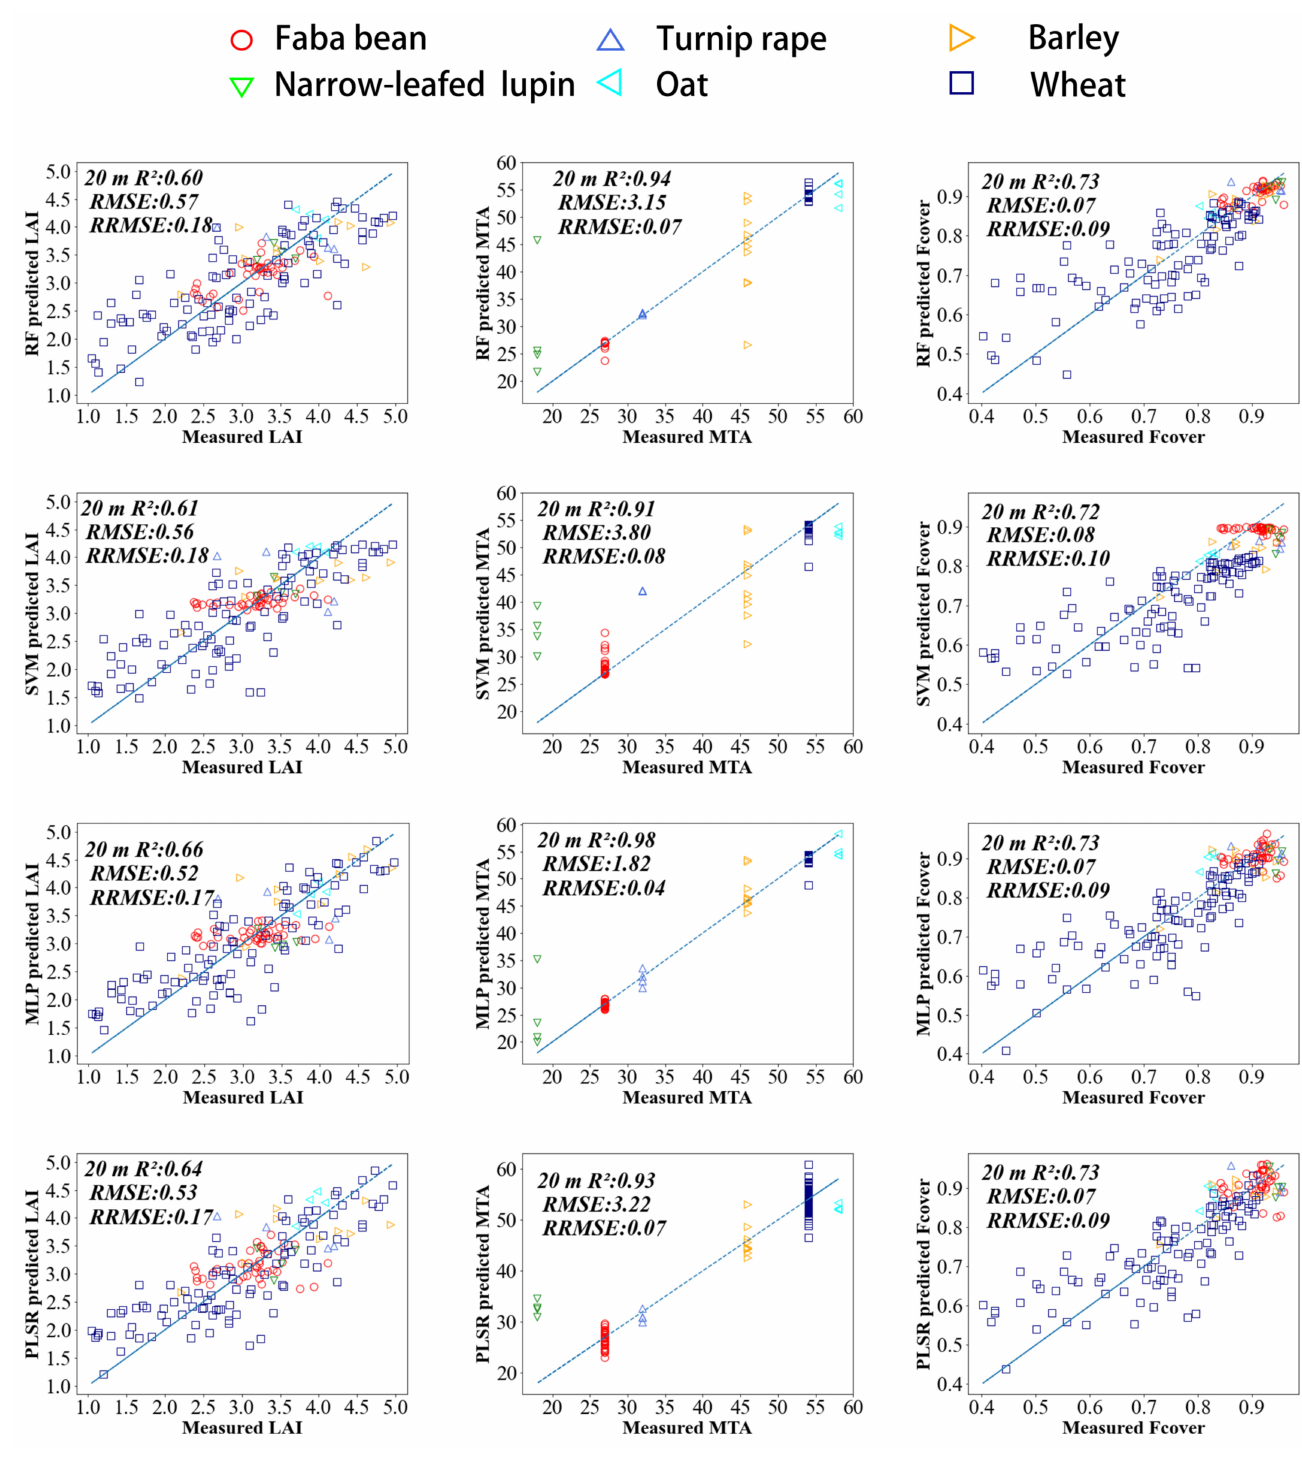
Figure 5. Canopy structure parameters estimated using simulated Sentinel-2 bands which have a resolution of 20 m or better in field-measured